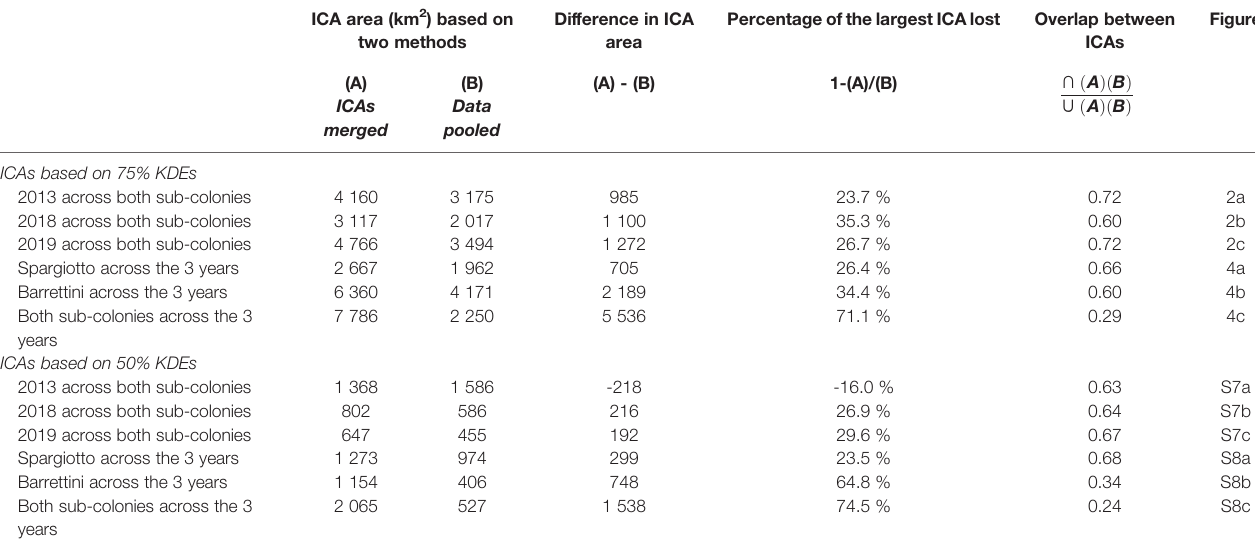
TABLE 1 | Comparison of ICAs when accounting or not for spatial and temporal heterogeneity in the dataset.